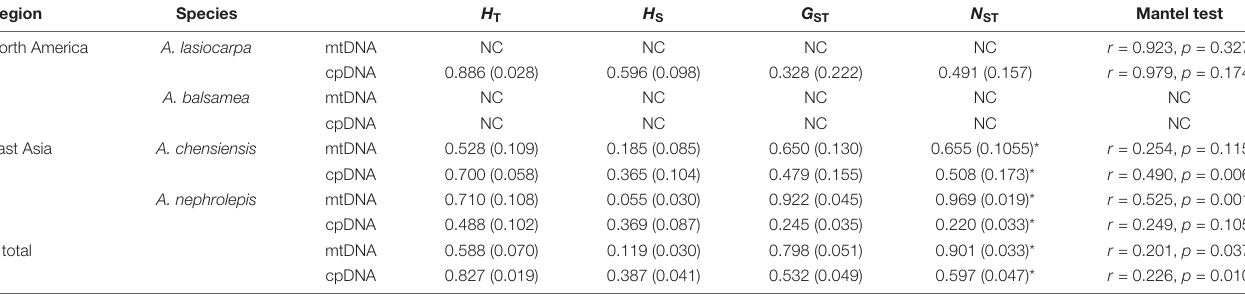
TABLE 2 | The results of genetic diversity estimates and Mantel tests. Region